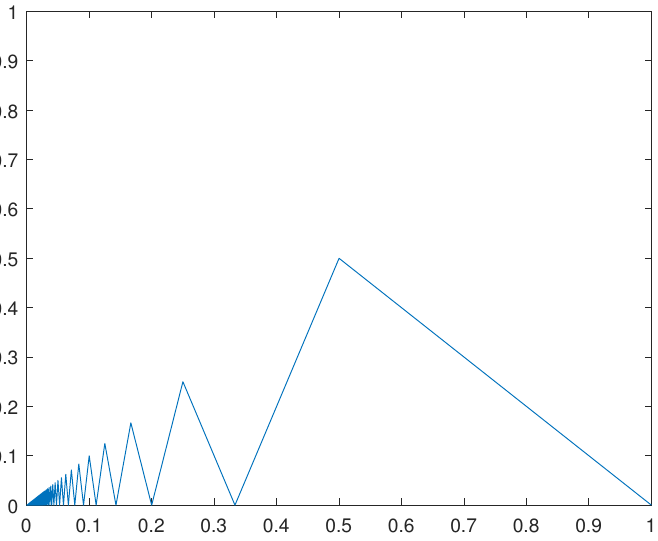
Figure 1. f 10000 ( x ) describes function sequence f n on I = [ 0,1 ] , when n is